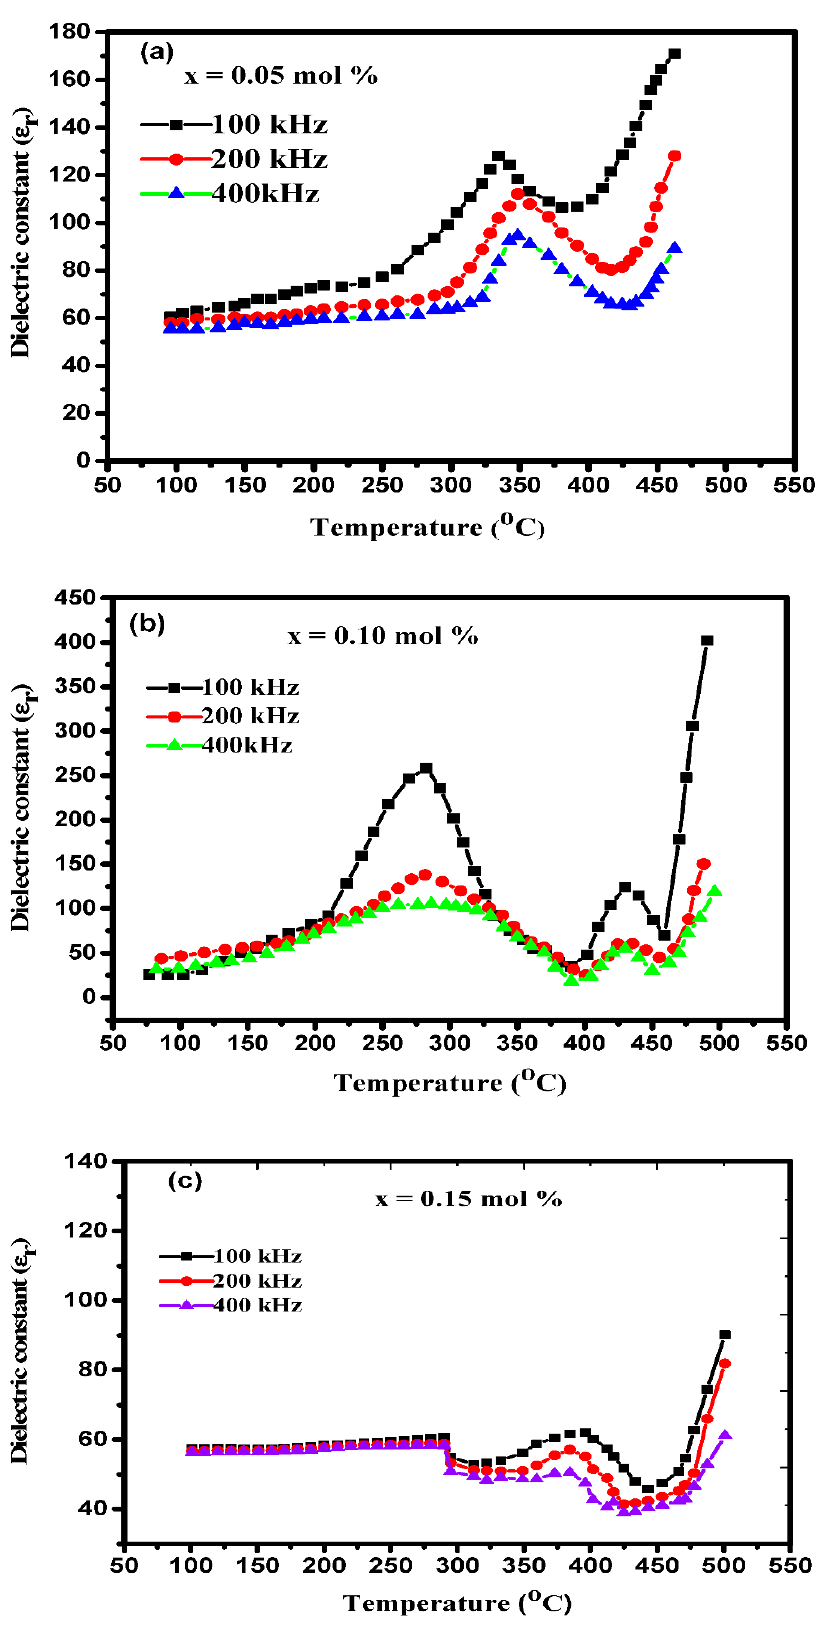
Figure 4. Dielectric constant of Co x :K 2 Ti 6 O 13 ceramics as a function of temperature; ( a ) is for Co 0.05 :K 2 Ti 6 O 13 , ( b ) is for Co 0.10 :K 2 Ti 6 O 13 and ( c ) is for Co 0.15 :K 2 Ti 6 O 13 .